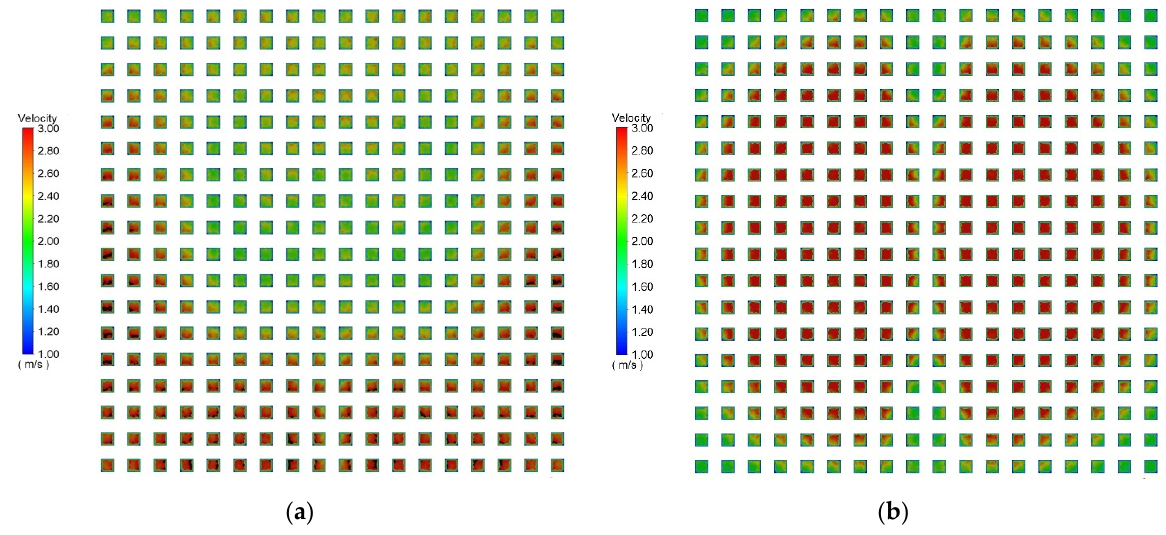
Figure 15. Velocity magnitude v in outlet plane of the air diffuser with plenum box with ( a ) side entry; ( b ) top entry.